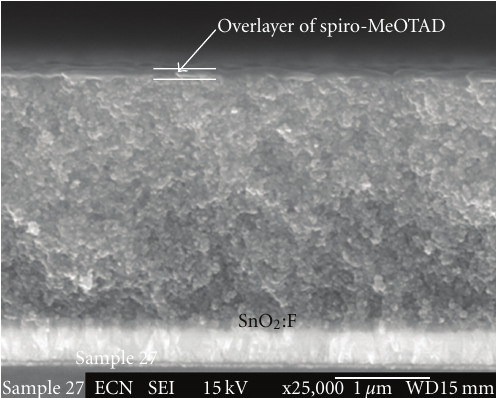
Figure 1: SEM cross-section of a ssDSC: the overlayer of the spiro- MeOTAD is visible on the top of the TiO 2